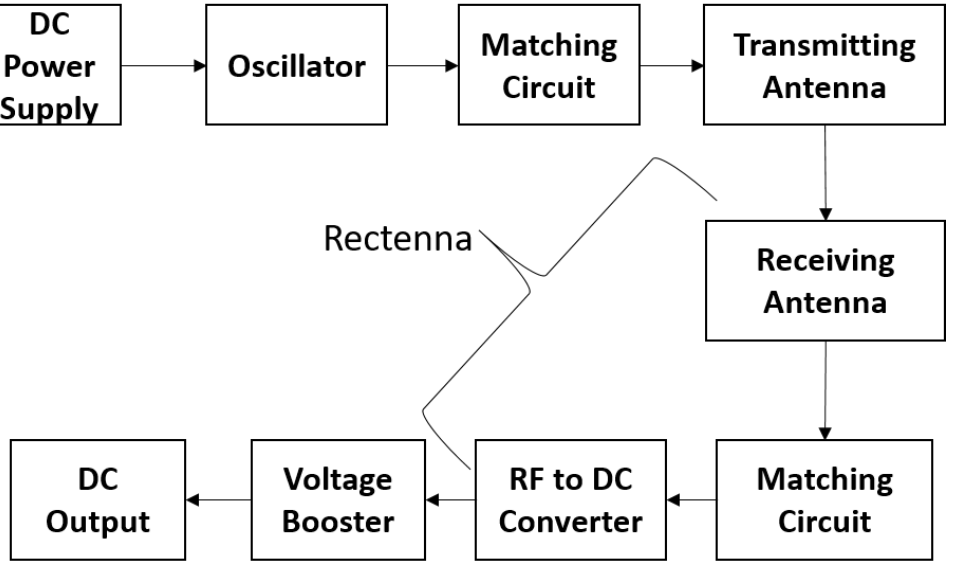
Figure 1. Energy harvesting process simplified.